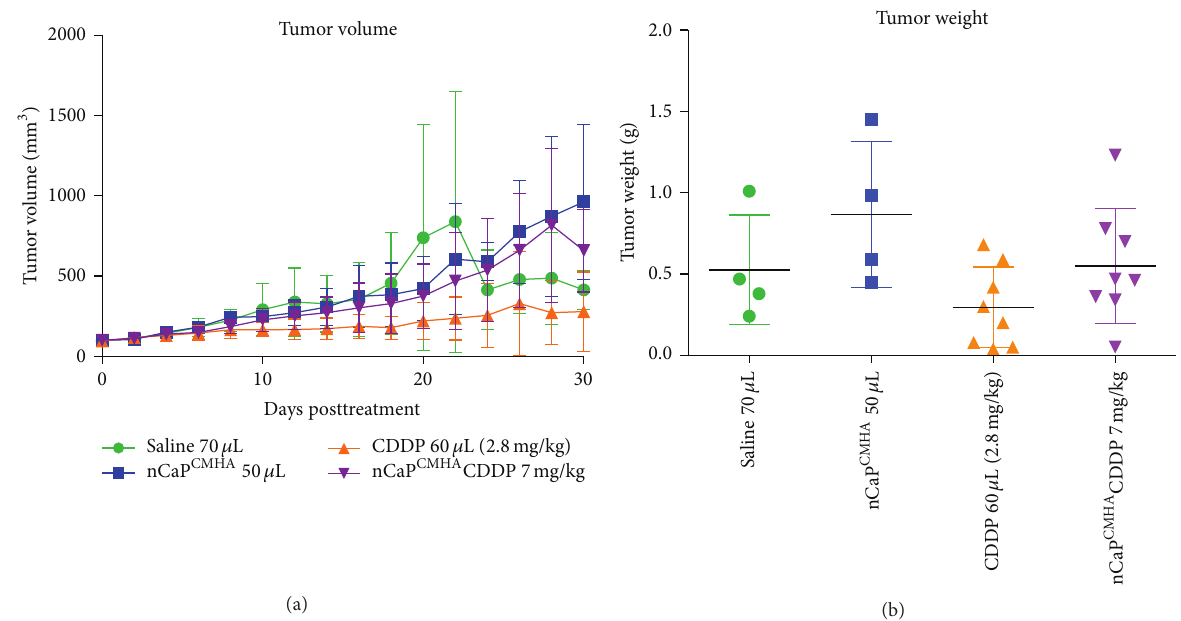
Figure 9: Efficacy study of nCaP CMHA CDDP conducted on J:Nu mice bearing BT-47 4 tumors. Animals were treated once when their EMT tumor volume reached 100 ± 10 mm 3 and were compared to 2.8 mg/kg CDDP administered near the tumor. Tumor volume, grooming, and weight loss were monitored every other day following treatment. (a) The graph depicts average tumor volume (mm 3 ) per group versus days posttreatment. The negative control saline IT (70 𝜇 L) had no effect on tumor growth. nCaP CMHA (60 𝜇 L) had no effect on tumor growth. CDDP at 2.8 mg/kg administered near the tumor delayed tumor growth. (b) Tumor weight at the end of the study or at time of euthanasia for the efficacy study shown in (a). Tumors were resected and weighed. Animals were euthanized if tumor diameter was measured > 2cm or at the completion of the study (day 30). No significant differences were found between